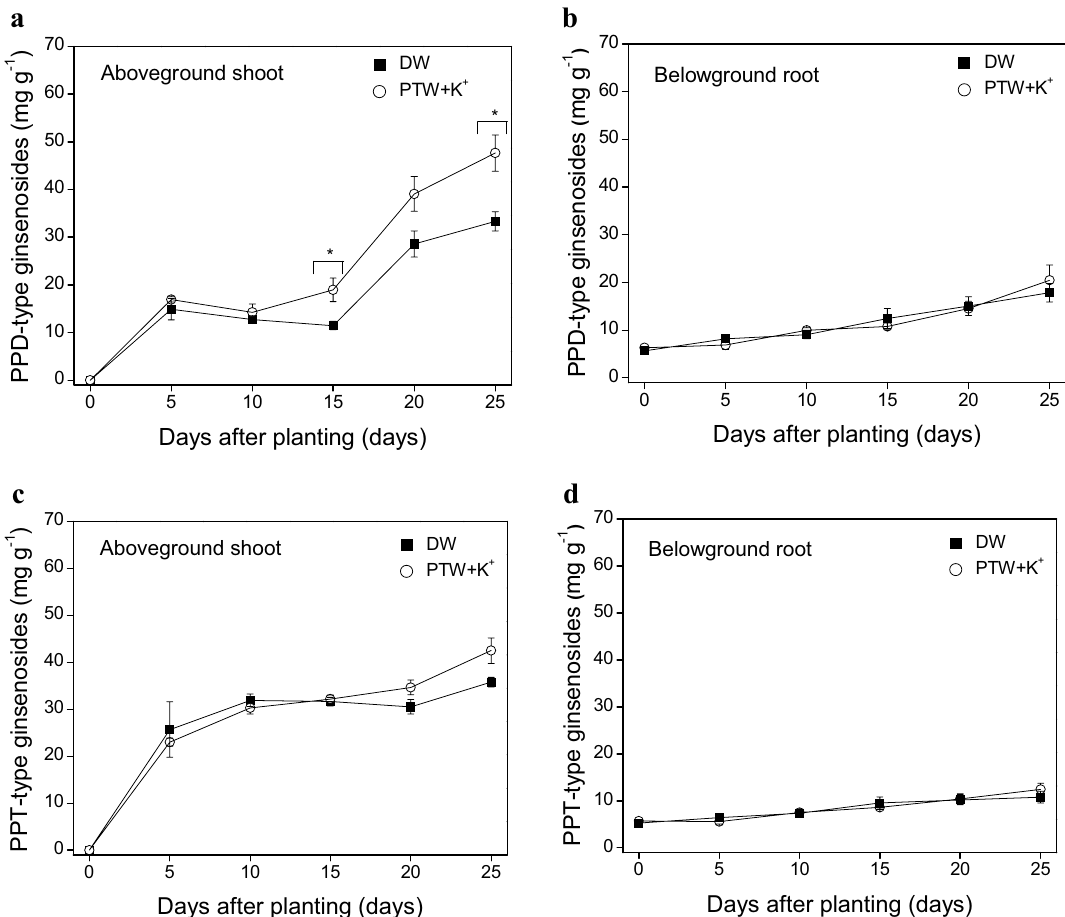
Figure 3. Protopanaxadiol (PPD)-type ( a , b ) and protopanaxatriol (PPT)-type ( c , d ) ginsenosides in the aboveground shoot ( a , c ) and belowground root ( b , d ) of Panax ginseng , each sprayed with deionized water (DW) and plasma-treated water (PTW) containing potassium ions (K + ) for 25 days. Each symbol represents the mean of four replicates with each replicate containing three shoots (or roots). The error bars represent the standard error of that mean. An asterisk indicates a significant difference between DW and PTW + K + at each day ( P <